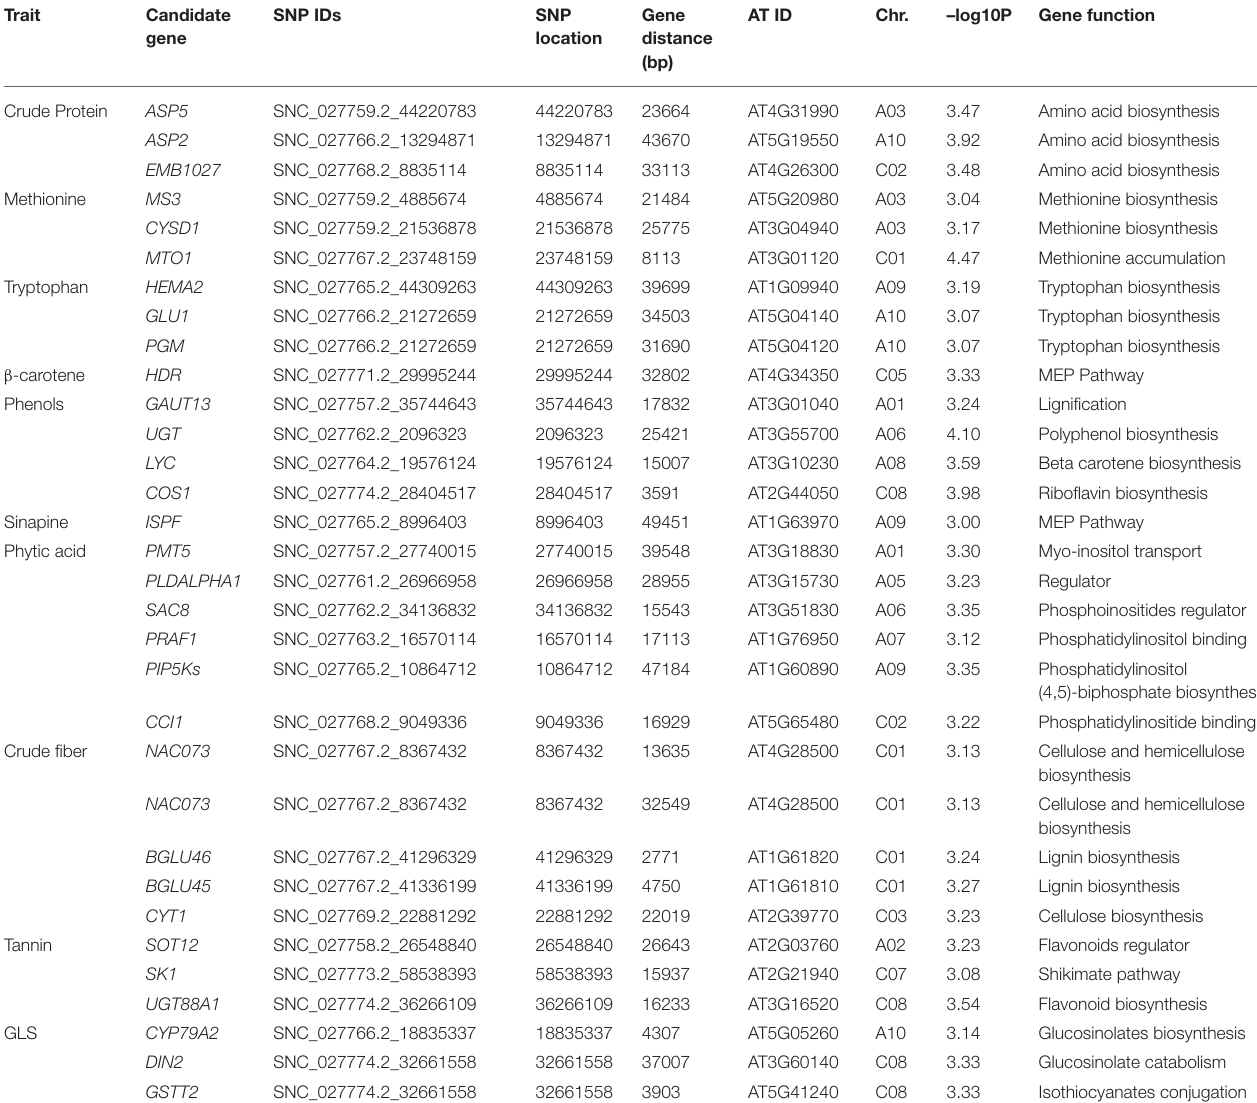
TABLE 3 | Summary of the significant candidate genes of seed quality traits.